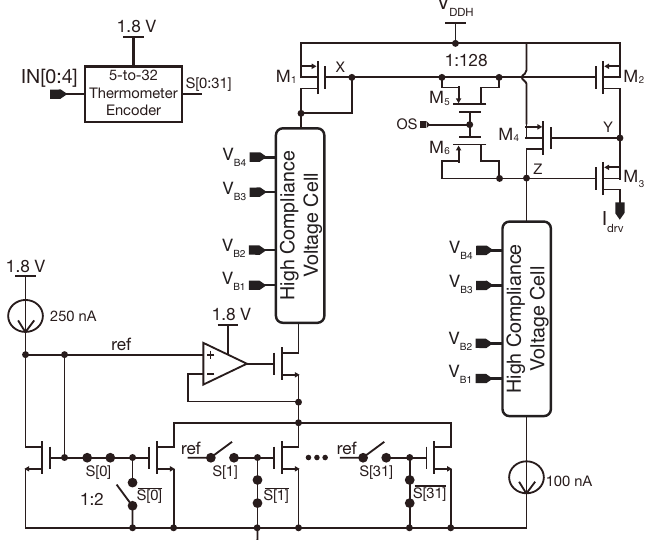
Figure 8. Schematic of the 5bits current-steering DAC, current mirror, and two HCVCs for interfacing LV and HV circuits. Biasing currents are copies of an on-chip 25nA self-biased current source [36].